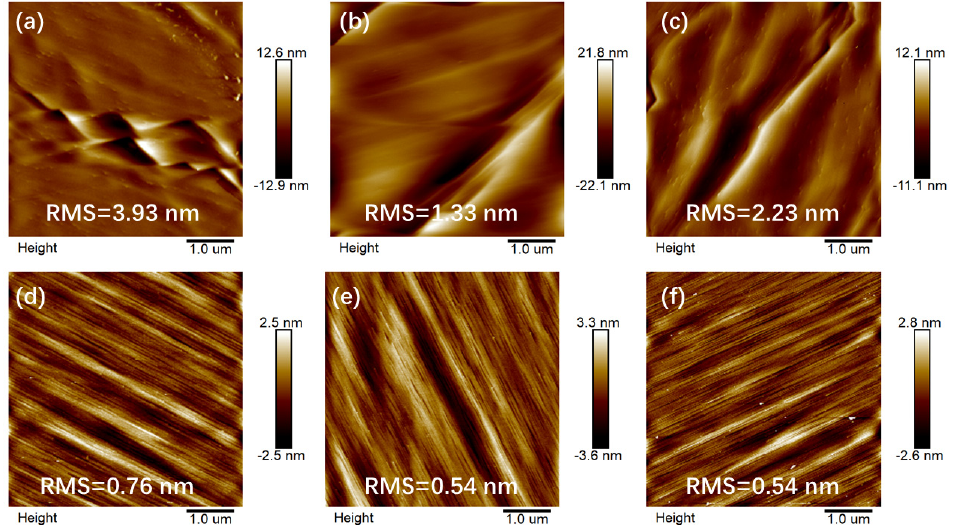
Figure 3. The 5 × 5 µm 2 AFM images of samples A ( a , d ); B ( b , e ); C ( c , f ) grown on 2M ( a – c ) and 4A ( d – f ) substrates. ( d – f )